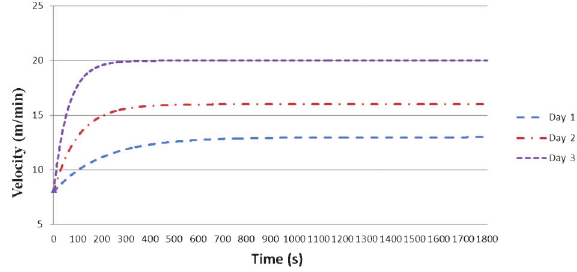
Figure 5. Construction of the three exponential exercise acceleration training